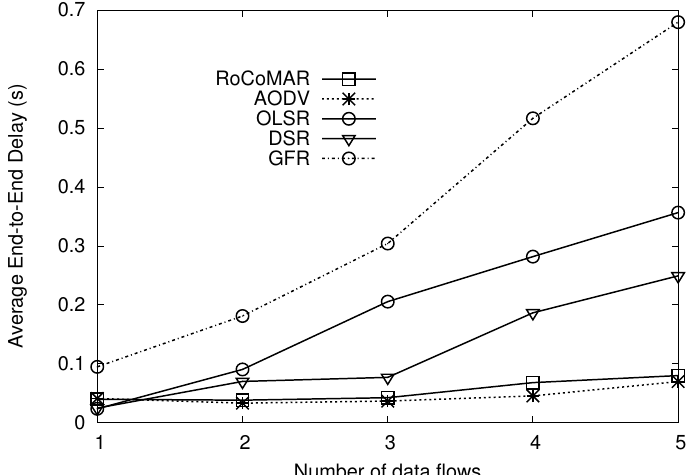
Figure 12. Effects of the number of data flows on average end-to-end